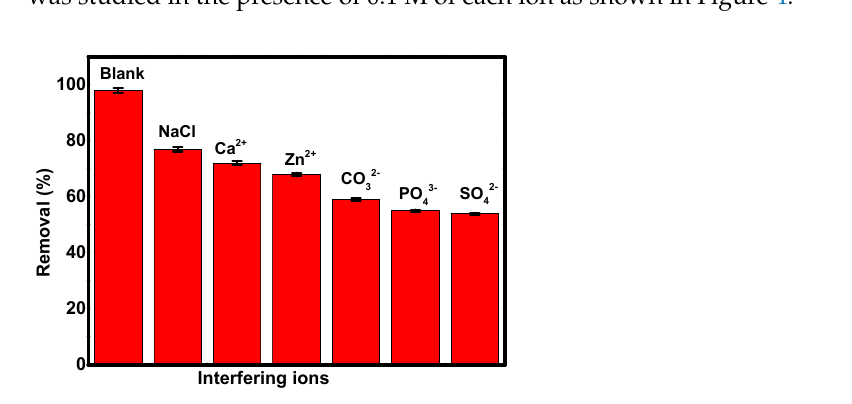
Figure 4. The effect of interfering ions on the Cr(VI) removal over the surface of ppy/NC nanocom-